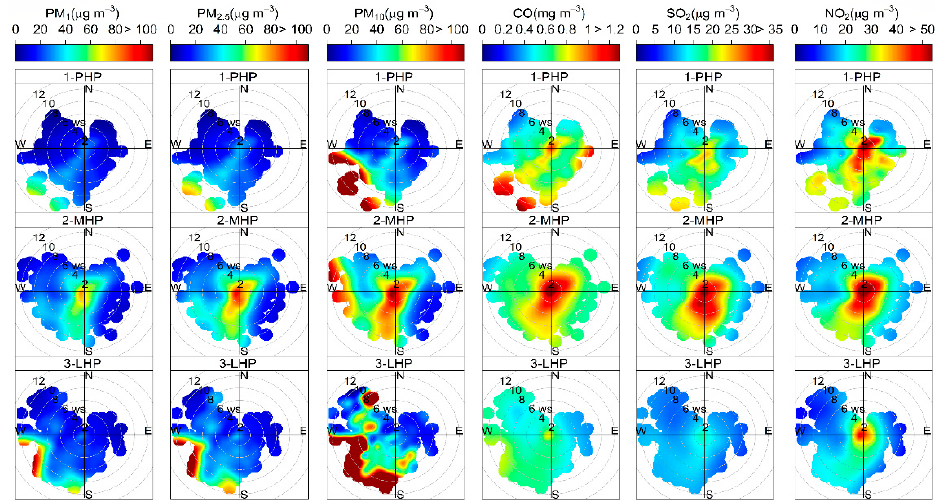
Figure 4. Bivariate polar plots of atmospheric pollutants with wind direction and speed during PHP, MHP and MHP and LHP.